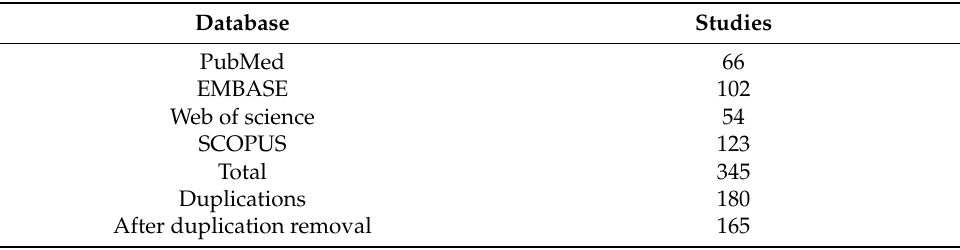
Table A1. Detailed search